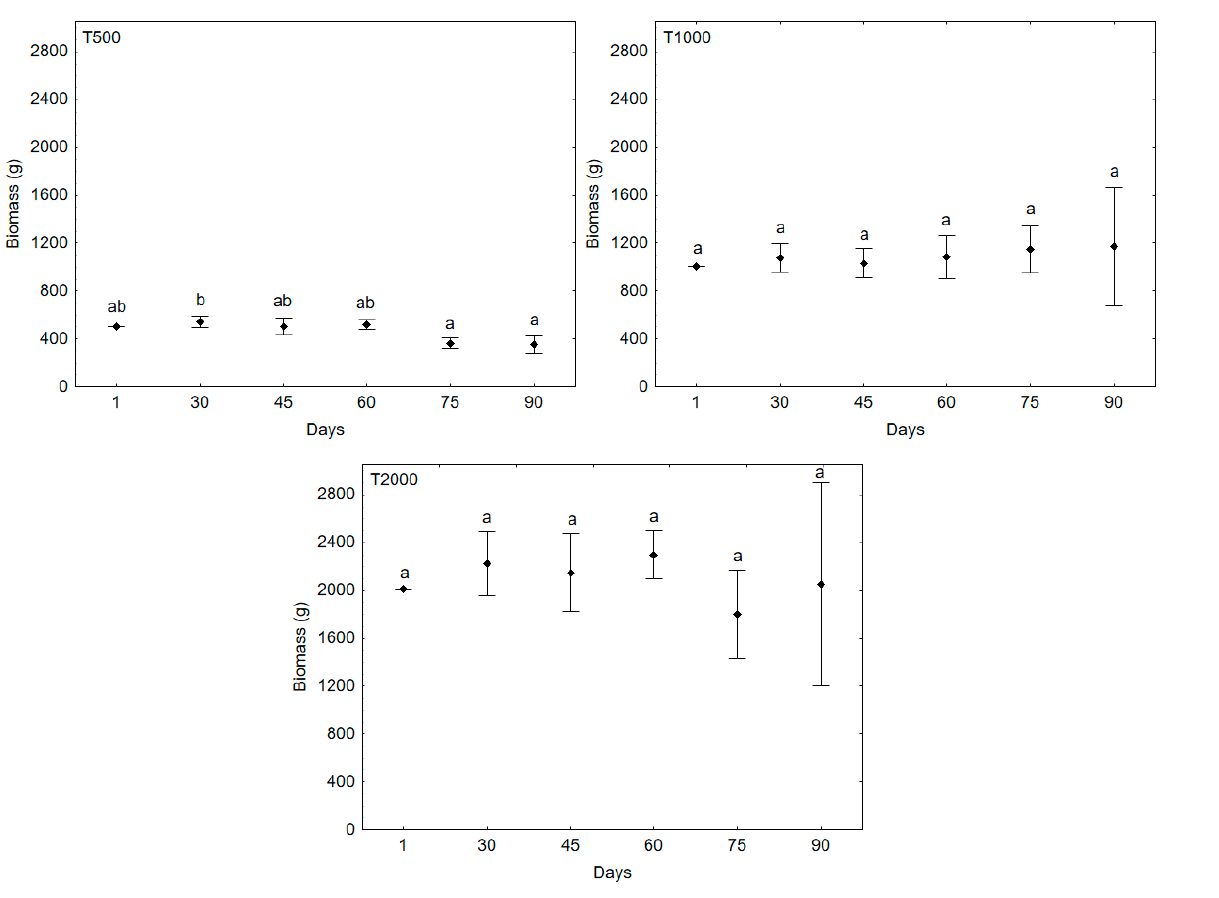
Figure 2. Mean (±SD) of G. birdiae wet biomass throughout the experimental period of 90 days. T500: 100 shrimp/m 2 and 500 g/m 2 of G. birdiae ; T1000: 100 shrimp/m 2 and 1000 g/m 2 of G. birdiae ; T2000: 100 shrimp/m 2 and 2000 g/m 2 of G. birdiae . Different letters indicate a significant difference between sampling periods according to the Tukey test ( p < 0.05).